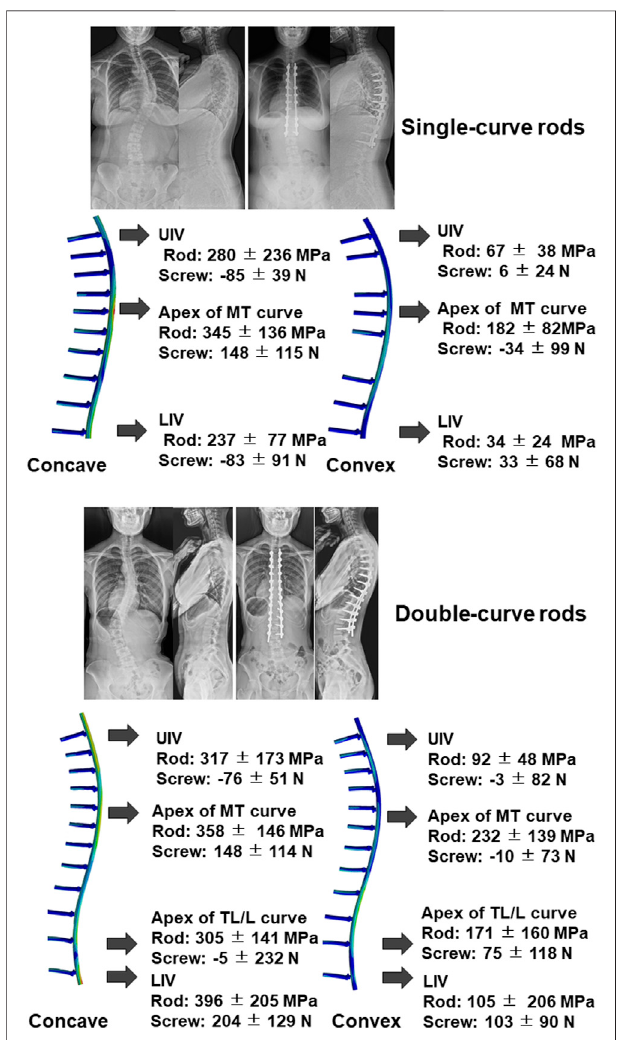
FIGURE 4 | Representative images of radiograph and simulation model using single-curve rod (upper) and double-curve rods. Results of rod stress andscrewforcesanalysisofall47caseswerealsopresented.Positivevaluein the screw force means pull-out force. UIV; upper instrumented vertebra, MT; main thoracic, LIV; lowest instrumented vertebra, TL/L; thoracolumbar/